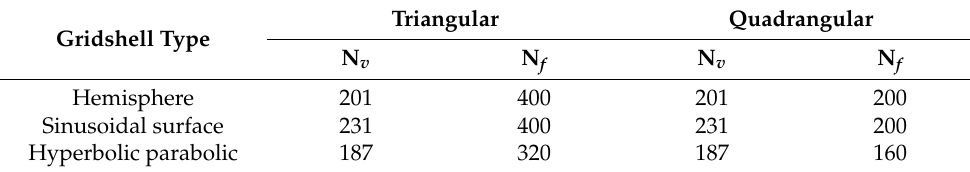
Table 3. The number vertices and faces in all the generated